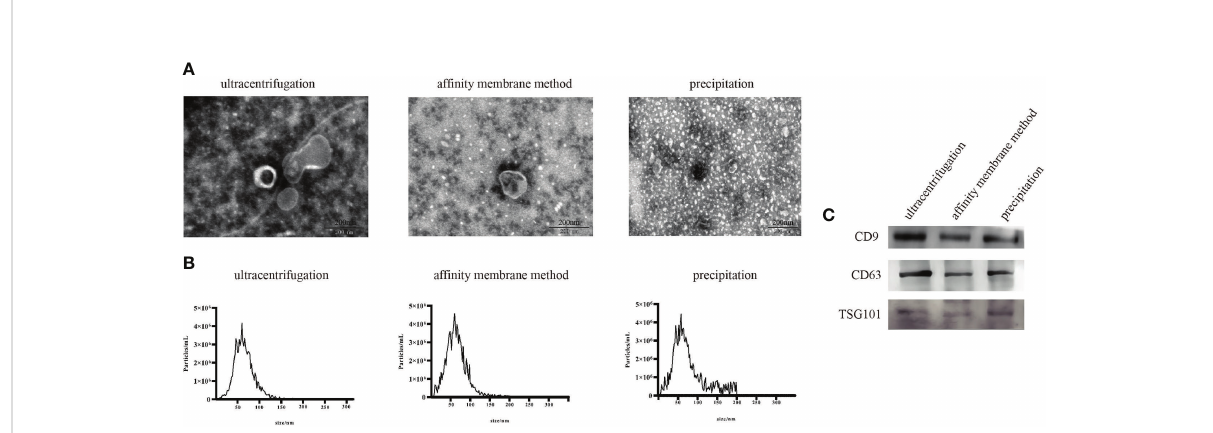
FIGURE 1 Characterization of exosomes extracted using three exosome extraction methods. (A) Physical examination of the isolated exosomes. (B) NTA of the isolated exosomes. (C) Western blot results of the isolated exosomes.